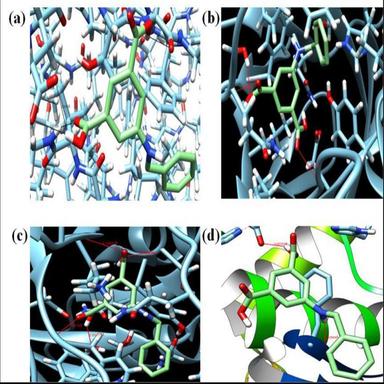
Ligand H2L embedded in the active sites of (A) 2DPK, (B) 4DBS, (C) 4DBU, (D) 4DIK proteins.